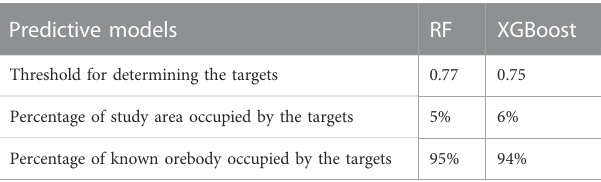
TABLE 5 P-A plot parameters of the RF28 and XGBoost11 predictive